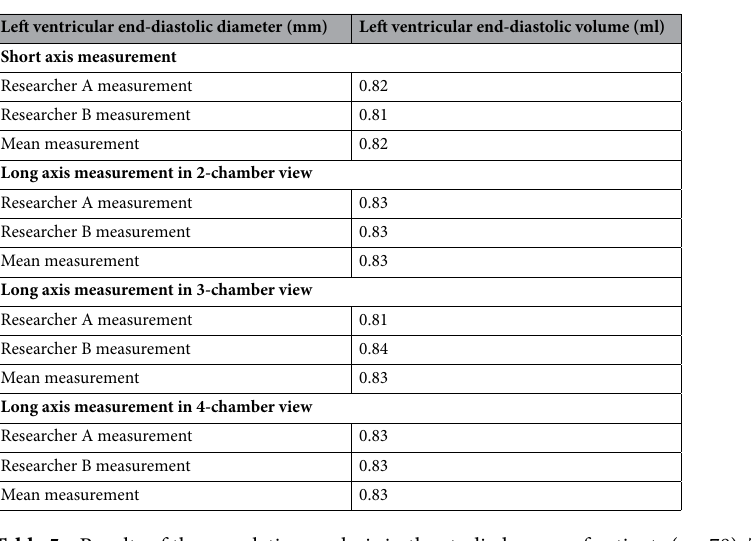
Table 5. Results of the correlation analysis in the studied group of patients (n = 78). The table shows the correlation coefficient of statistically significant correlations (p < 0.05).